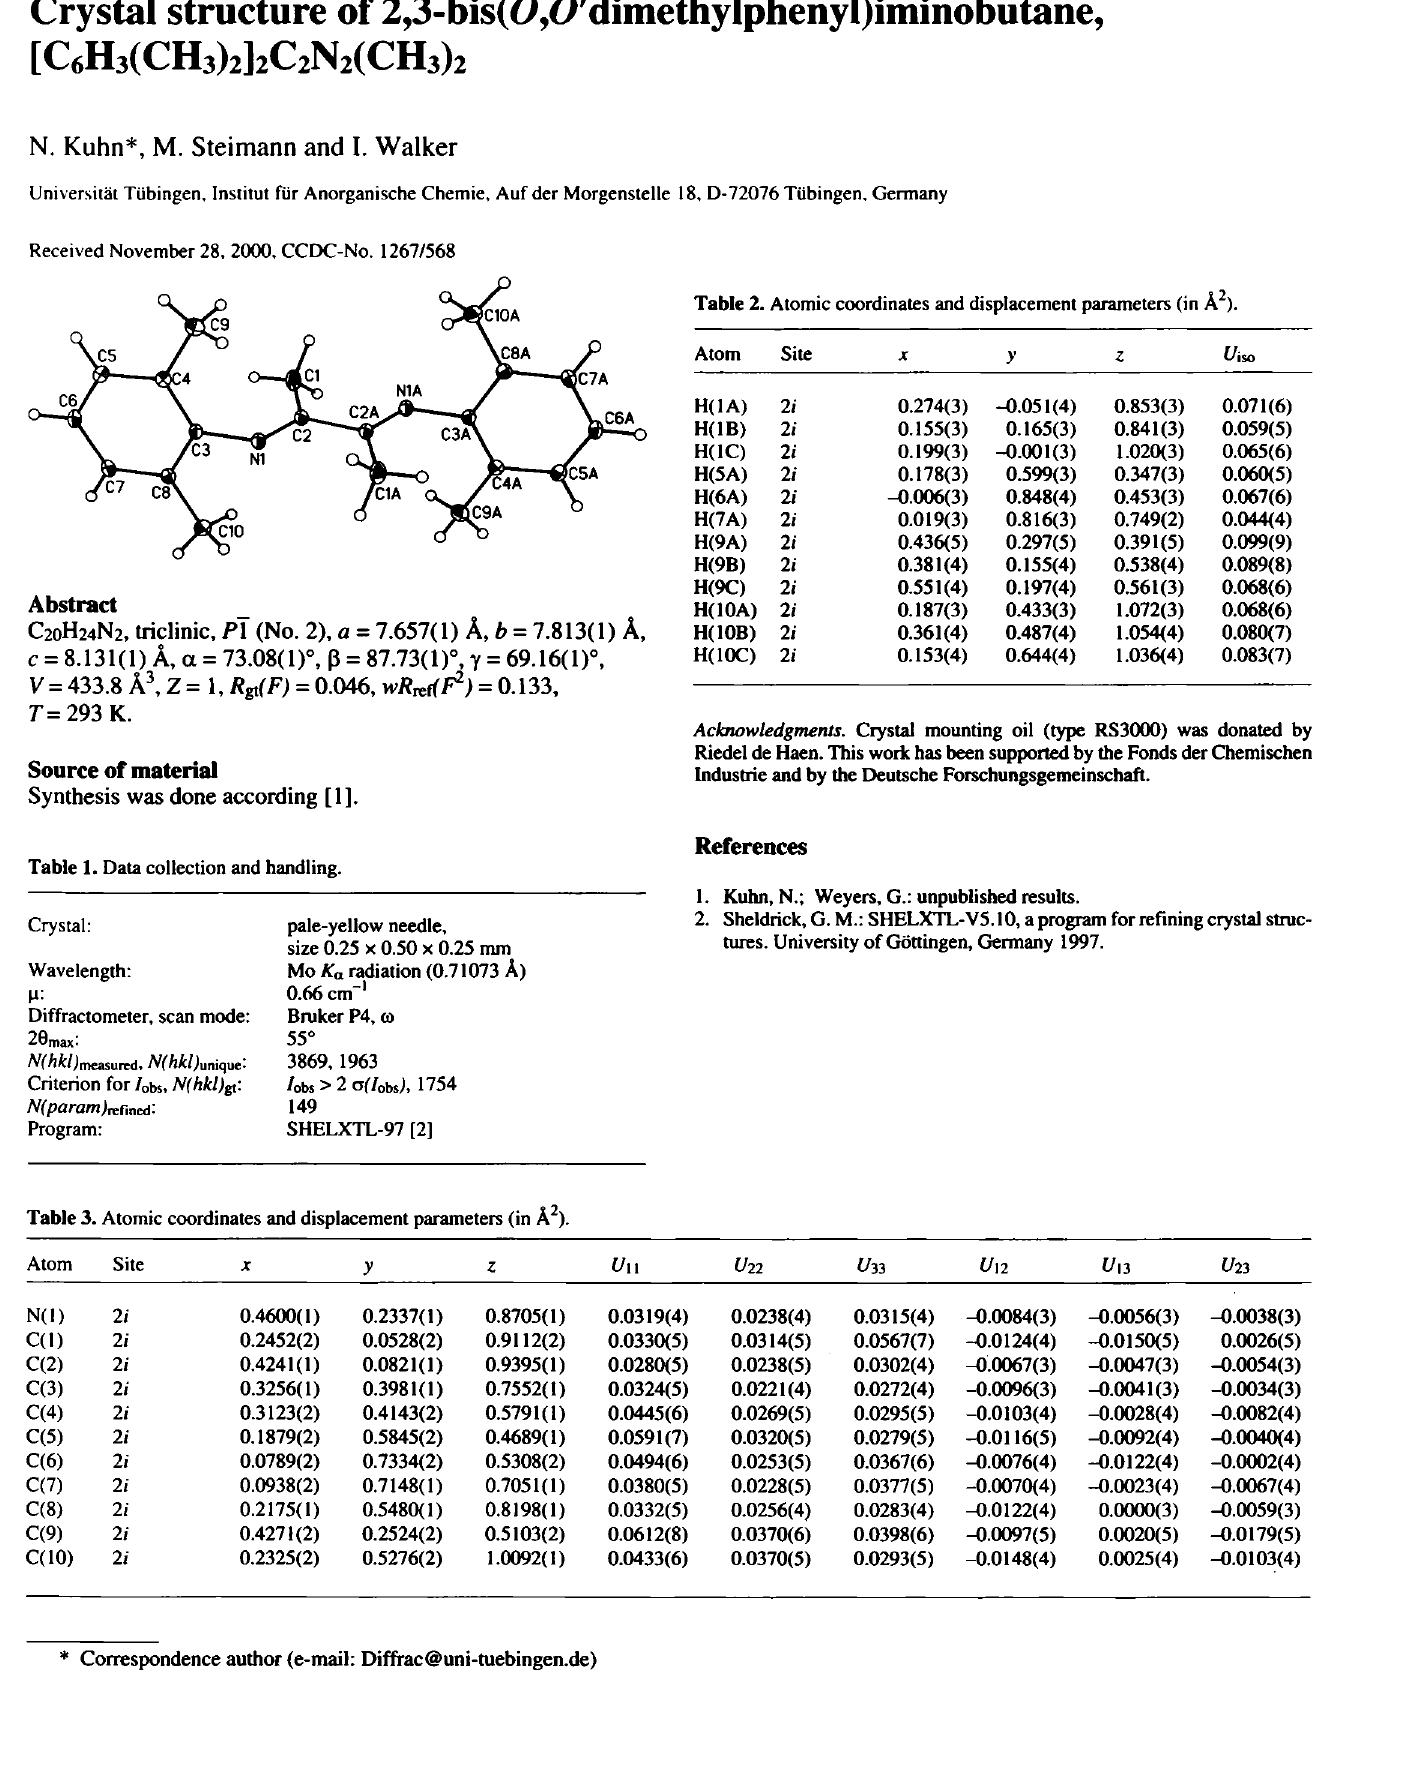
Table 3. Atomic coordinates and displacement parameters (in Ä 2